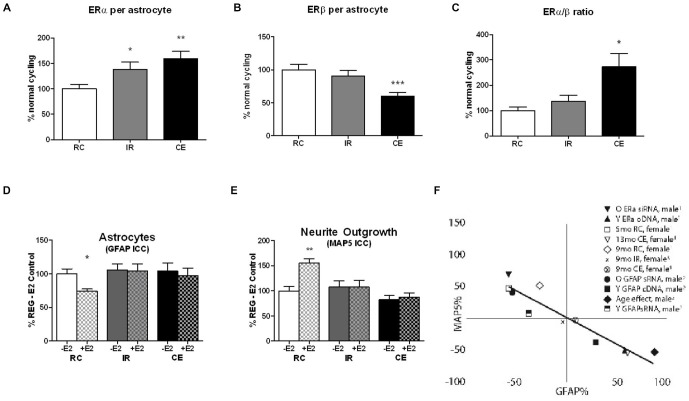
(A–C)
In vivo ERα and ERβ expression in cerebral cortex astrocytes of perimenopausal female rats, aged 9 month differ by ovarian cycle status: regular cycles (RC) 4–5 day irregular cycles (IR) >5 day; constant estrus (CE) (Nelson et al., 1982; Finch, 2014). Astrocyte ERs in primary visual cortex in layers 1 and 2/3, RC vs. IR vs. CE; 4 brains per cycle status; Data is expressed as % regularly cycling (RC) control; mean+SEM; ***p < 0.001; **p < 0.01; *p < 0.05. RC and CE data published in Arimoto et al. (2013), Figure 7 (n.b. CE is denoted as AC, ibid.). The IR data are from Arimoto et al. (2011) and the thesis of Jason Arimoto (USC, 2012). (D,E)
In vitro GFAP expression and neurotrophic activity (MAP5, neurite outgrowth) in mixed glia from 9 month old perimenopausal rats of different cycling status: RC vs. IR vs. CE. Mixed glial were co-cultured with E18 neurons; 4 cultures, 4 brains per cycling stage group. Data expressed as % RC control; mean + SEM; **p < 0.01; *p < 0.05. GFAP responses to 100 pM E2 in mixed glia from 9 month rats: The RC responded to E2 with decreased GFAP, but age-matched IR and CE were unresponsive. Neurite outgrowth (MAP5) was increased by 100 pM E2 in RC, but not in age-matched IR and CE. The RC and CE data were published in Arimoto et al. (2013), Figure 6 (n.b. CE is denoted as AC, ibid.). The IR data are from Arimoto et al. (2011) and the thesis of Jason Arimoto (USC, 2012). (F) Reciprocal relationships between GFAP and neurite outgrowth (MAP5), plotted as % change relative to controls in that experiment. RC and CE data published in Arimoto et al. (2013), Figure 8. New data on 9 month IR are calculated from (D,E).